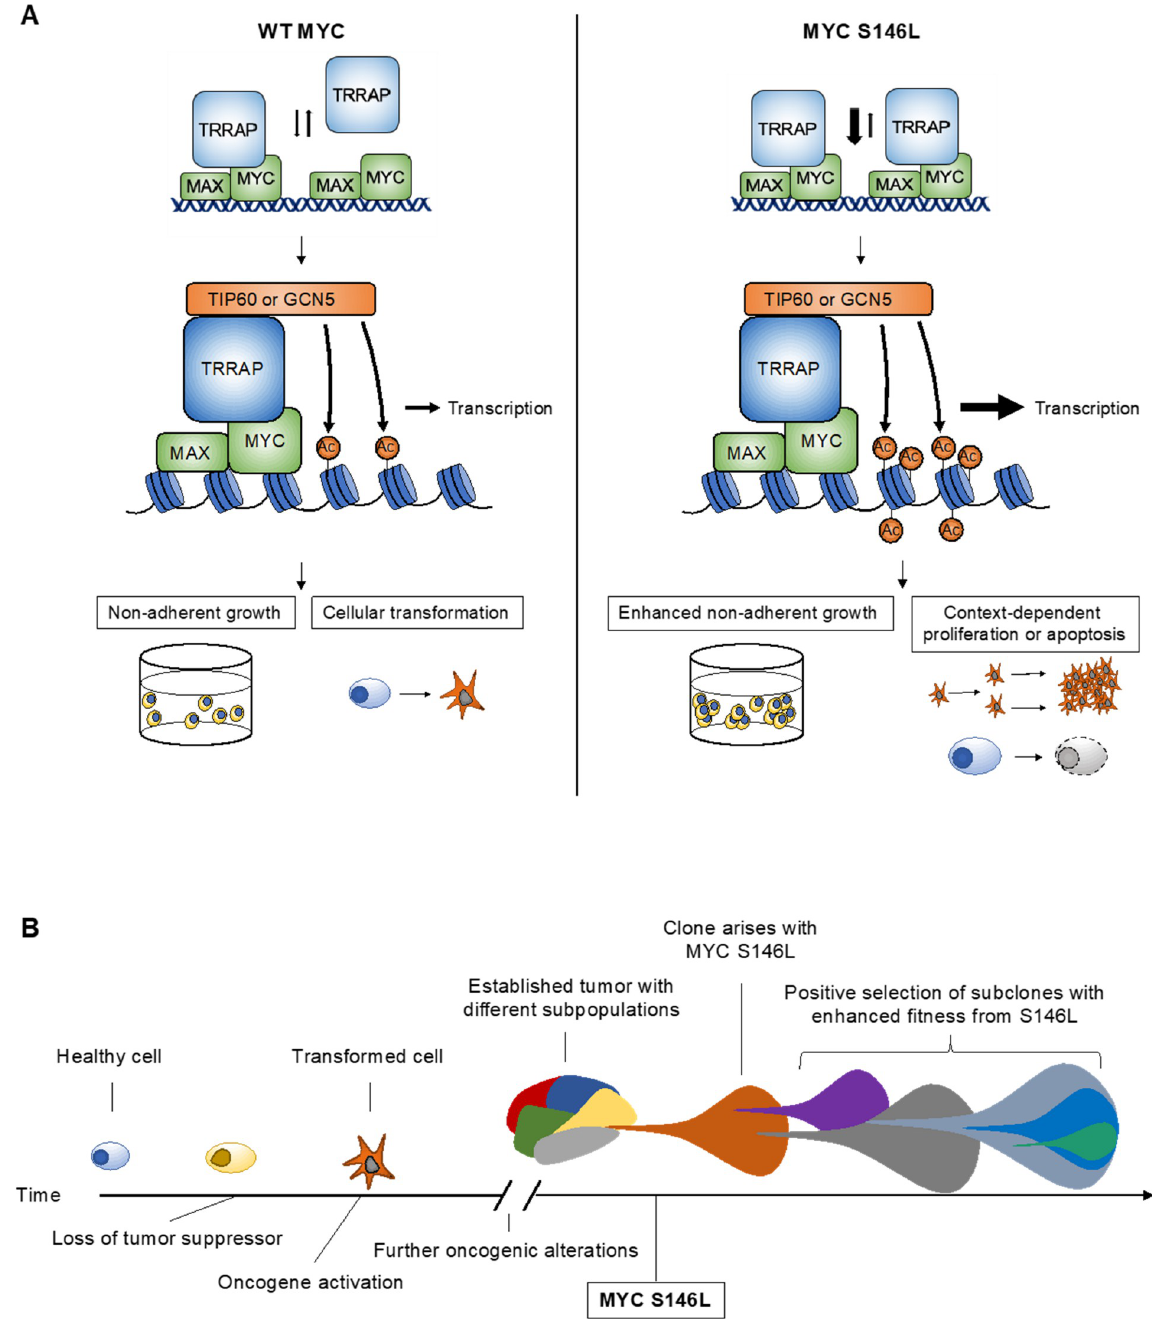
Fig 7. Proposed model of MYC S146L activity in transcription and cancer development. (A) Wild-type MYC likely exists in an equilibrium of TRRAP-bound and unbound states. Upon TRRAP recruitment, MYC directs the acetylation of proximal histones to promote transcription. Expression of oncogenic levels of WT MYC promotes non-adherent growth and cellular transformation. In contrast, MYC S146L promotes increased TRRAP affinity, likely leading to enhanced histone acetylation with a concomitant increase in the transcription of target genes. As a result, MYC S146L promotes increased fitness and growth in low attachment and likely augments both cell proliferation and apoptosis in a context-dependent manner. (B) Normal cells under oncogenic transformation following the deleterious genomic alterations, such as the loss of tumor suppressor function and the activation of oncogenes. Following this process, mutation of MYC S146L further activates transcription of MYC target genes. Subsequently, subclones tolerating this mutation are established and are endowed with increased fitness because of heightened MYC